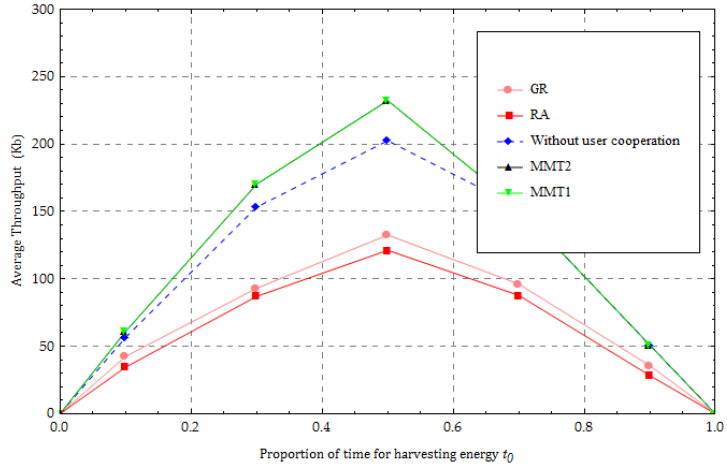
Figure 5. Change in the proportion of time for harvesting energy.